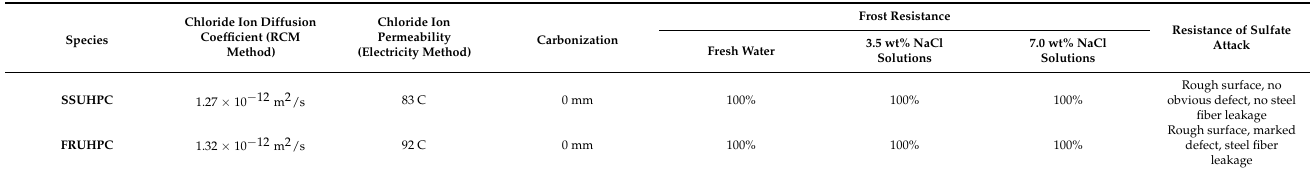
Table 7. Laboratory test results of